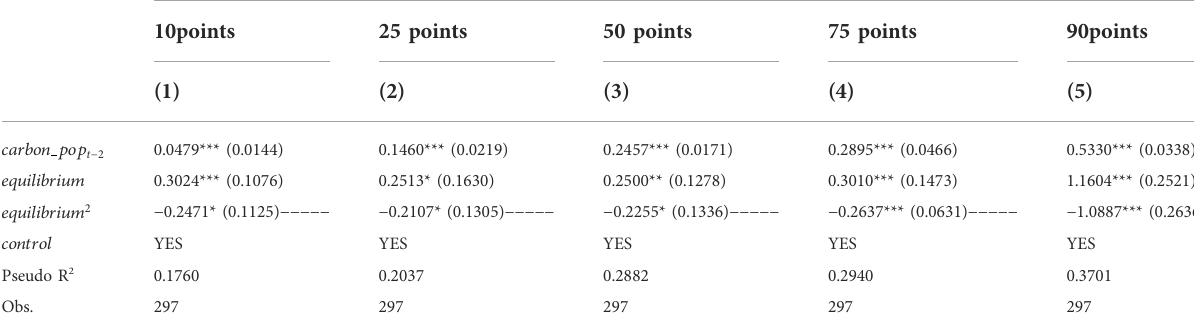
TABLE 3 Quantile regression estimation